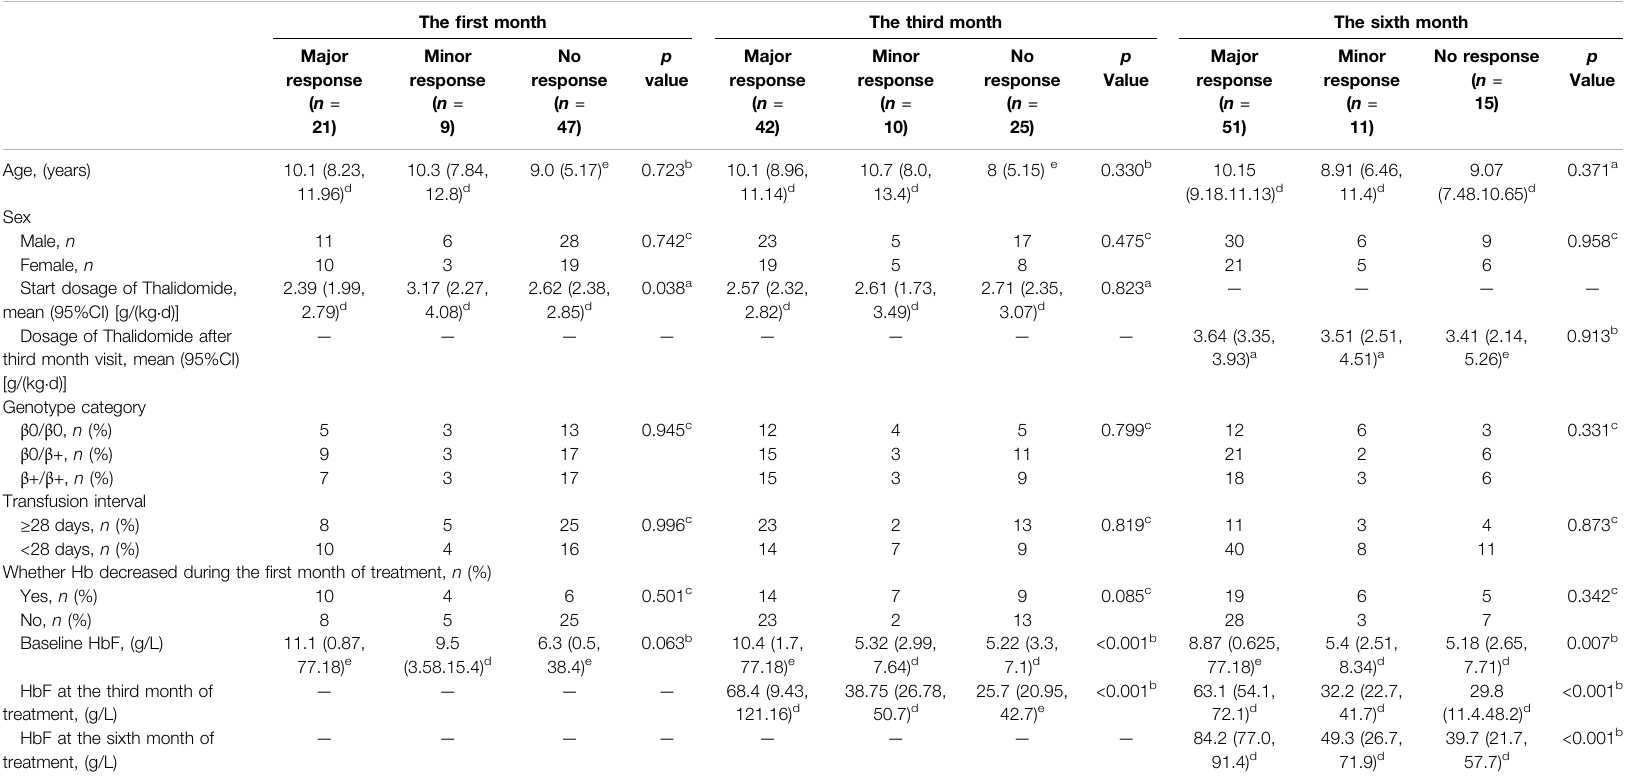
TABLE 2 | The analysis of parameters for response differences at the fi rst month, the third month and the sixth month.